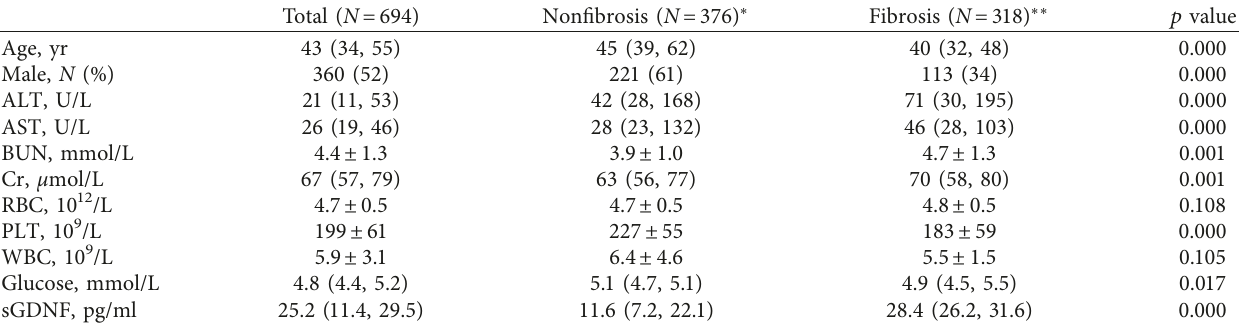
Table 1: Clinical demographics and clinical characteristics of patients in nonfibrosis and fibrosis groups.